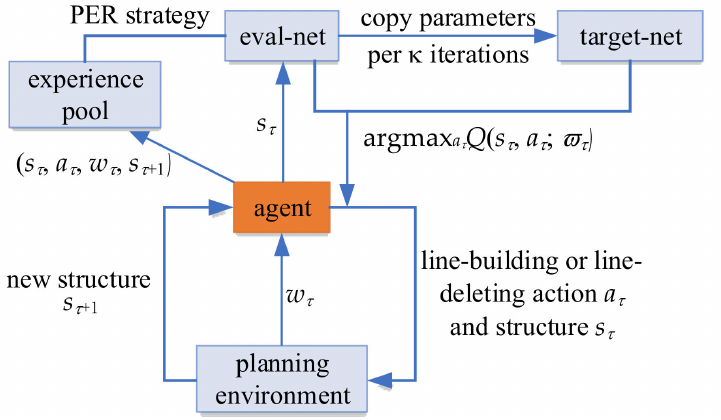
Figure 3. Transmission network expansion planning (TNEP) framework based on the DQN